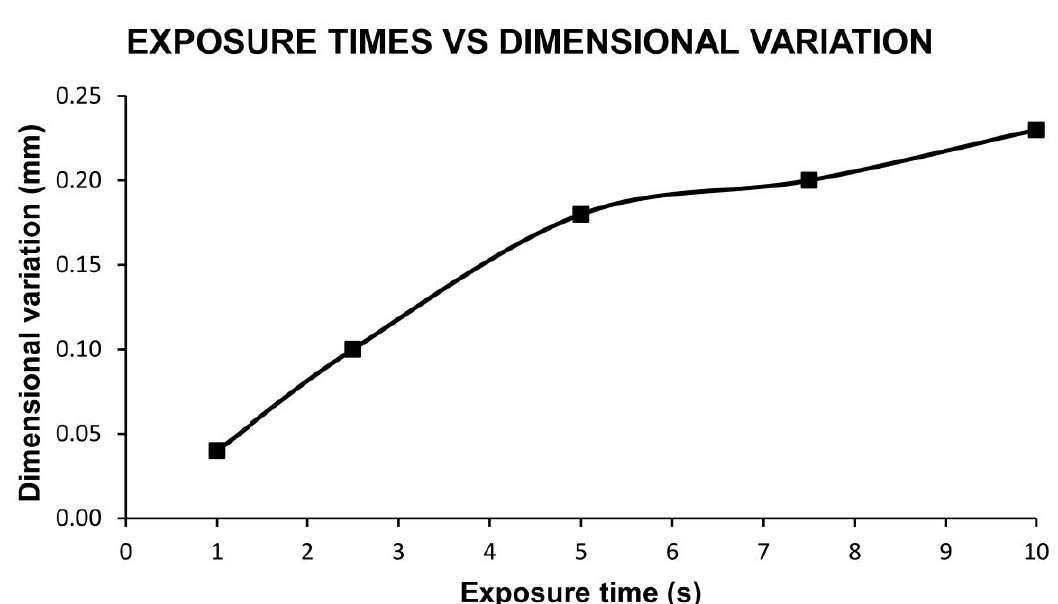
Figure 2. Dimensional variation for each exposure time and layer height of 0.18 mm.